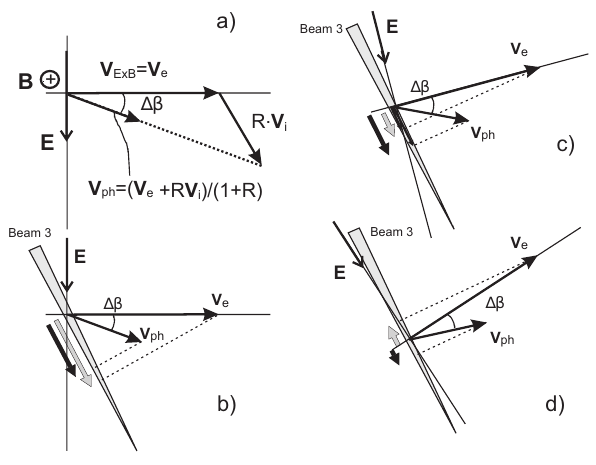
Fig. 8. A sketch illustrating the relationship between the V E × B and V ph velocity components projected onto the STARE beam 3: (a) A vector diagram showing the electron drift and ion drift contributions to the irregularity phase velocity V ph , according to the linear fluid theory, (b) A case when the V ph l-o-s component is less than the V E × B l-o-s component, (c) A case of “overspeed” when the V ph l-o-s component is larger than the V E × B l-o-s component and (d) a case when the V ph l-o-s component has different polarity with the V E × B l-o-s